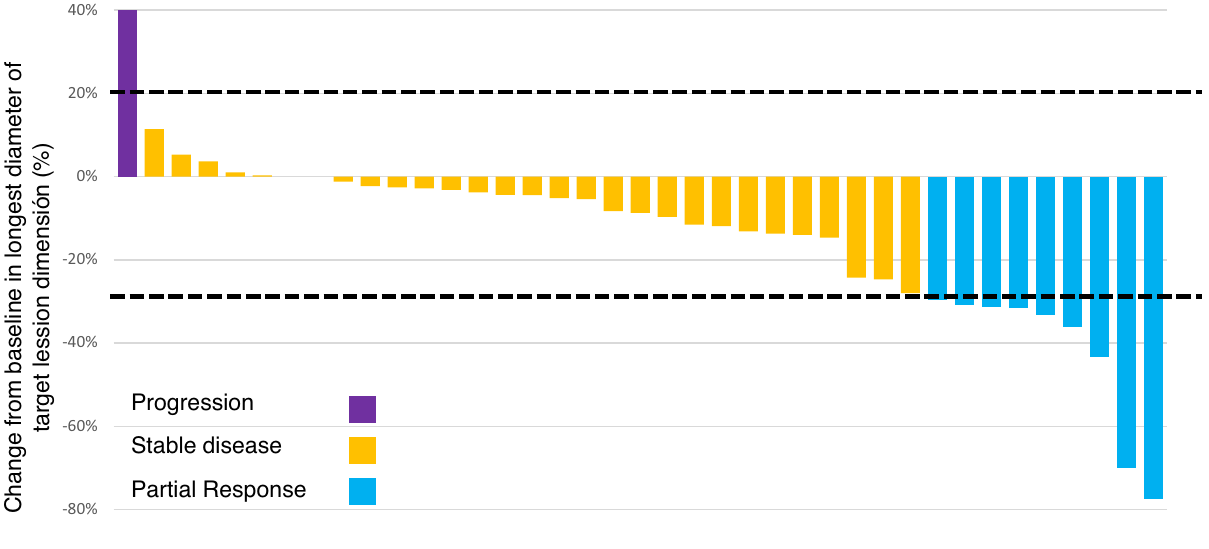
of diameters of target lesions) and for partial response (at least 30% decrease), respectively. Partial response (blue); Stable disease (yellow) and Progression (purple). Source data are provided as a Source Data fi